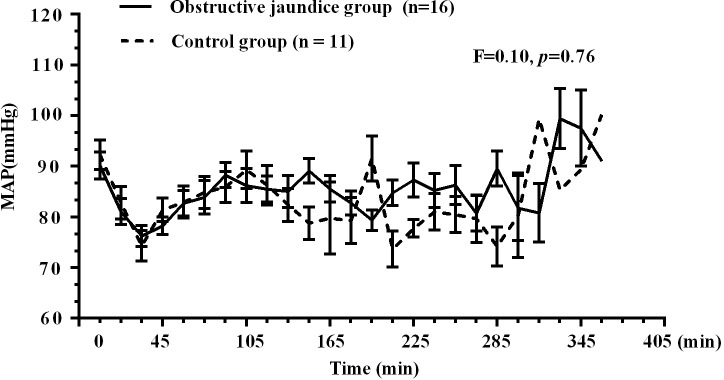
Hemodynamic changes of patients during surgeries for both group (p = 0.76).